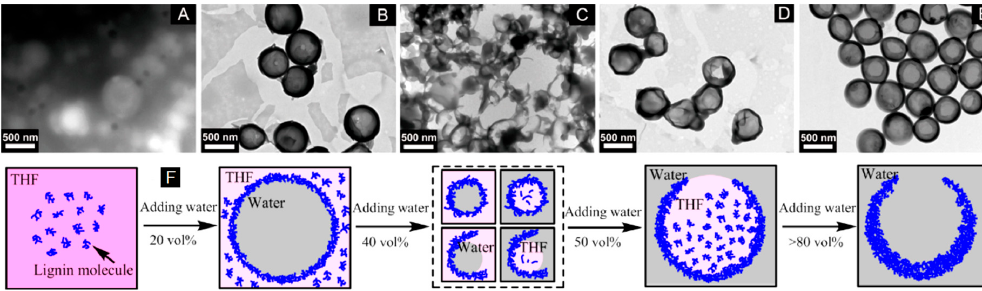
Figure 4. Transmission electron microscopy (TEM) images of the samples obtained from the dispersions at different water contents at an initial lignin concentration of 0.5 g/L. Water content: ( A ) 0 vol %, ( B ) 20 vol %, ( C ) 40 vol %, ( D ) 50 vol %, ( E ) >80 vol %, after removing tetrahydrofuran (THF). ( F ) Schematic representation of the lignin hollow nanosphere’s formation process in THF/H 2 O. Reprinted with permission from Xiong et al. [51]. Copyright 2017 American Chemical Society.